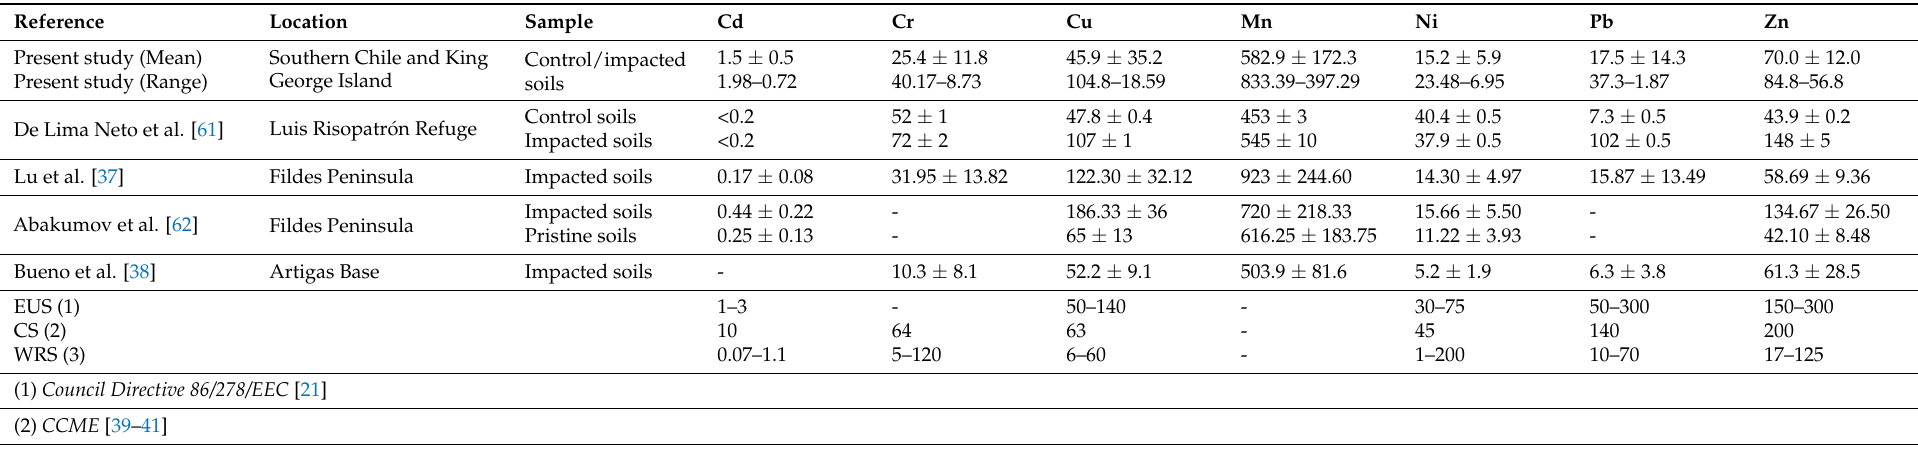
Table 1. Selected references of the MTE concentrations (mg/kg in dry weight) in soils. Values are mean ± standard deviation and ranges). Impacted soils are principally by scientific stations. Values ranges are according to the EUS (European Union Standard) and WRS (World Range for non-polluted soils), and mean values are according to CA (Canadian Standard).